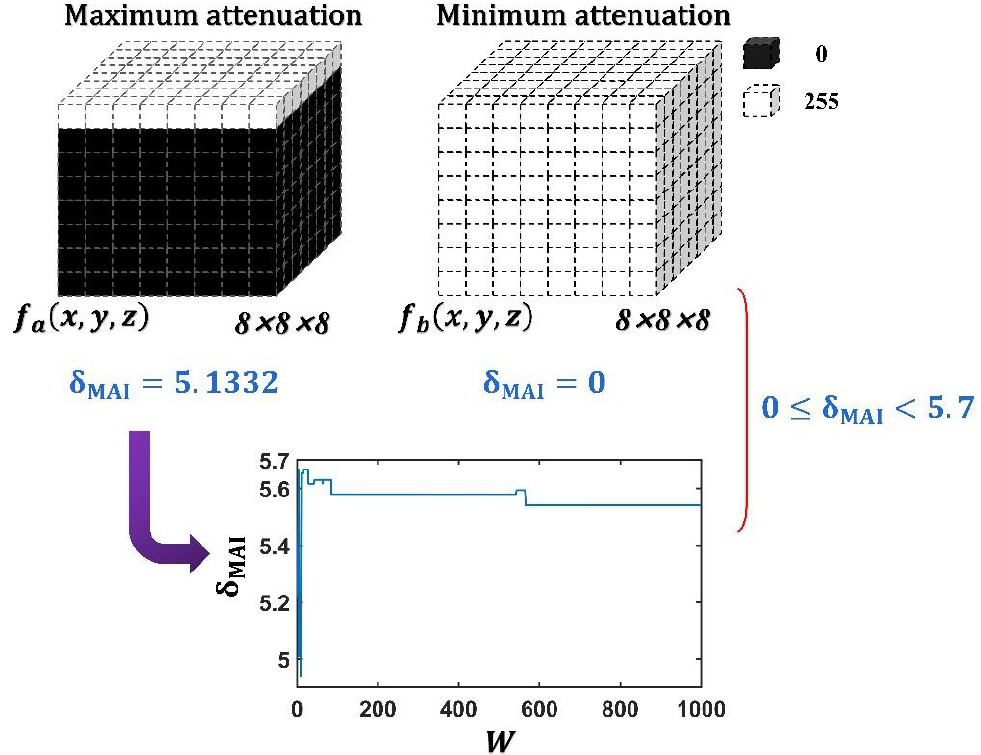
Figure 4. The principle of the value range of MAI : 𝒇 𝒂 (𝒙,𝒚, 𝒛) is the schematic diagram of maximum OCT signal attenuation, 𝒇 𝒃 (𝒙,𝒚,𝒛) is the schematic diagram of minimum OCT signal attenuation.